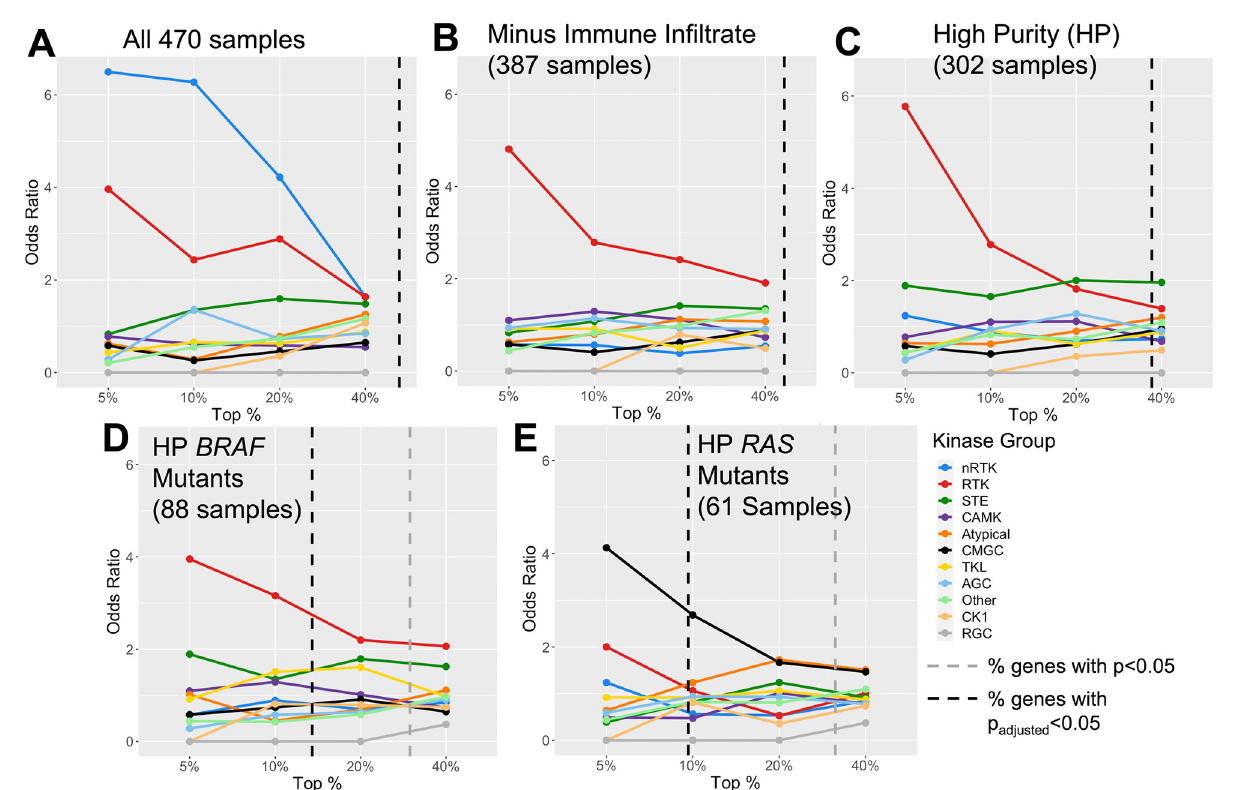
Fig 2. Kinase group enrichment for differential expression of primary and metastatic tumors differs by sample set. Depicted are the odds ratios for each kinase group in the top 5%, 10%, 20%, and 40% of kinase genes, ranked by p-value. This indicates that the strongest DE enrichment is concentrated in nRTKs for all 470 samples, RTKs for high purity and BRAF mutant samples, and CMGC kinases for RAS mutant samples. Enrichment data collected at the four percentile points are independent of p-value; the percent of genes that have significant DE (p < 0.05) before and after p-value adjustment are shown by the gray and black dotted lines respectively. Sample type (primary tumor or metastatic) was the only model variable for the DESeq2 results.